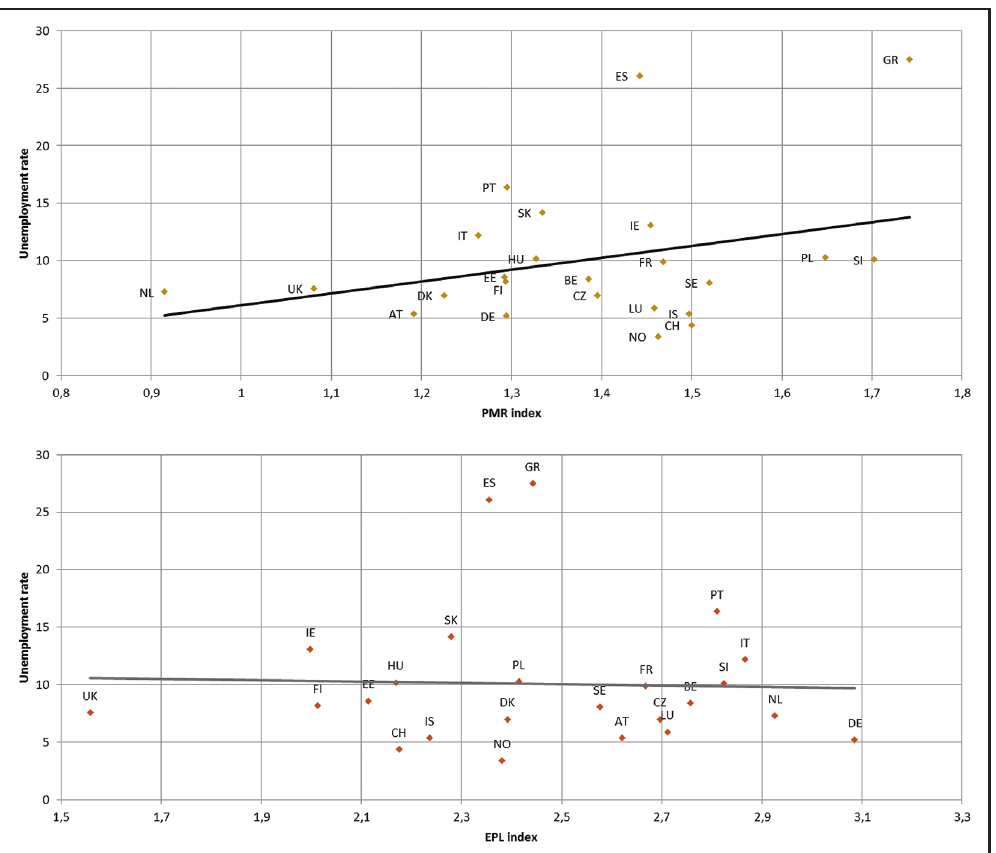
Relationship between unemployment rate and regulatory indices (2013).